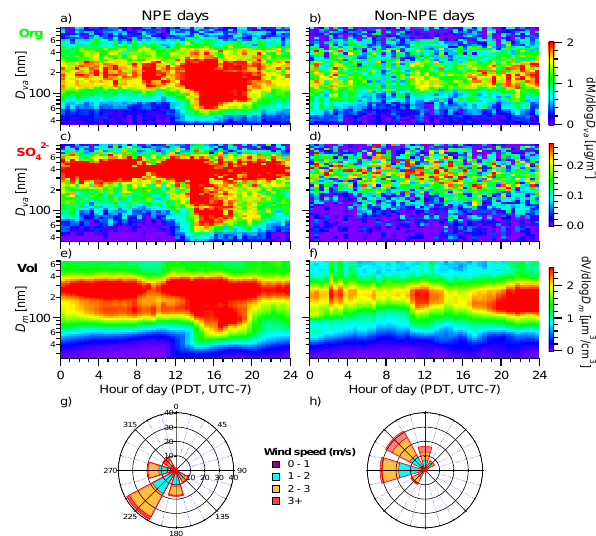
Figure 6. Diurnal size distributions of (a, b) Org, (c, d) SO 2 − (e, f) particle volume concentrations, and (g, h) daytime wind rose plots (08:00–20:00PDT) for NPE days (left panel) and non-NPE days (right panel) at